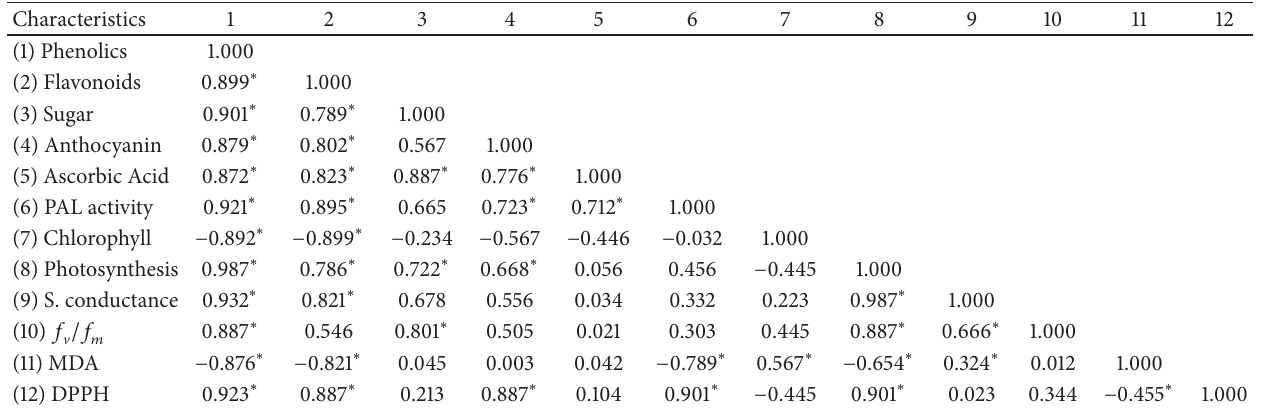
Table 2: Pearson’s correlation parameters.